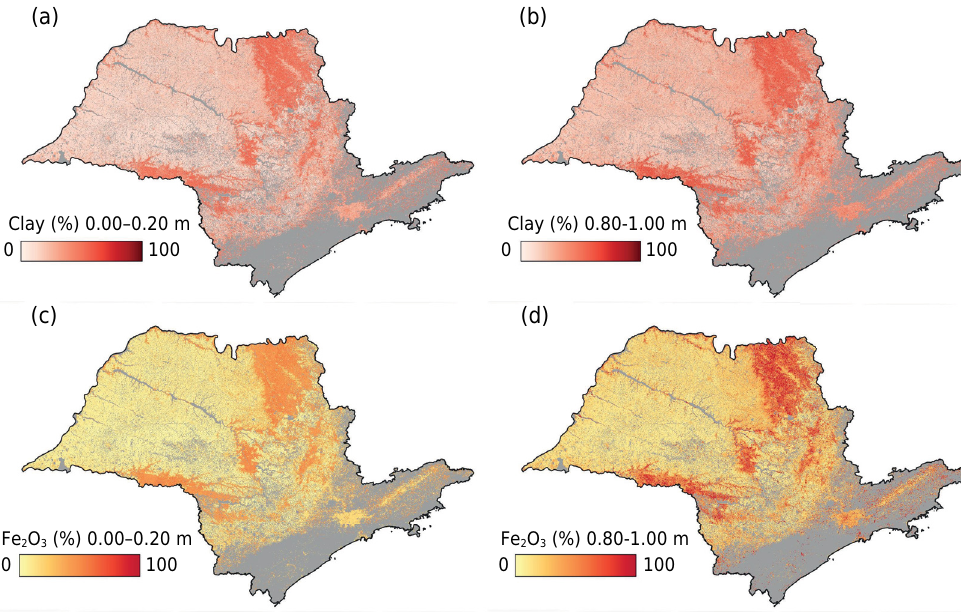
Figure 3. a) Predicted clay content for the 0.00-0.20 m layer; b) predicted clay content for the 0.80-1.00 m layer; c) Predicted Fe 2 O 3 content for the 0.00-0.20 m layer; d) Predicted Fe 2 O 3 content for the 0.80-1.00 m layer. The readers are referred to figure 1 for spatial